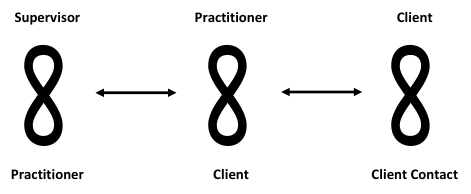
Figure 29: Parallel